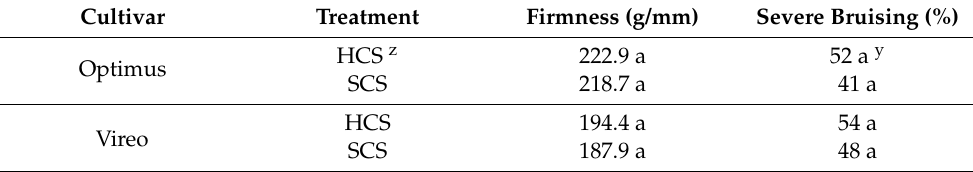
Table 4. Firmness and unmarketable blueberries due to severe internal bruising after commercial packing for “Optimus” and “Vireo” (Harvest 2 only). Fruit held overnight at 10 ◦ C, commercially packed, held 24 h at 24 ◦ C, then measured for firmness and bruise severity (severe bruise: ≥ 20% sliced surface discoloration).